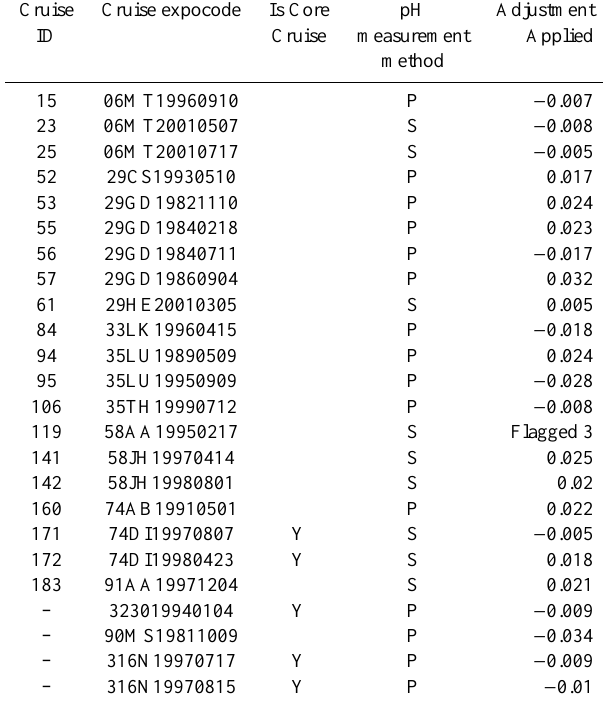
Table 4. Adjustments applied to individual cruise files. “P” or “S” are acronyms for pH measurement method, and refer to Potentio- metric or Spectophotometric techniques